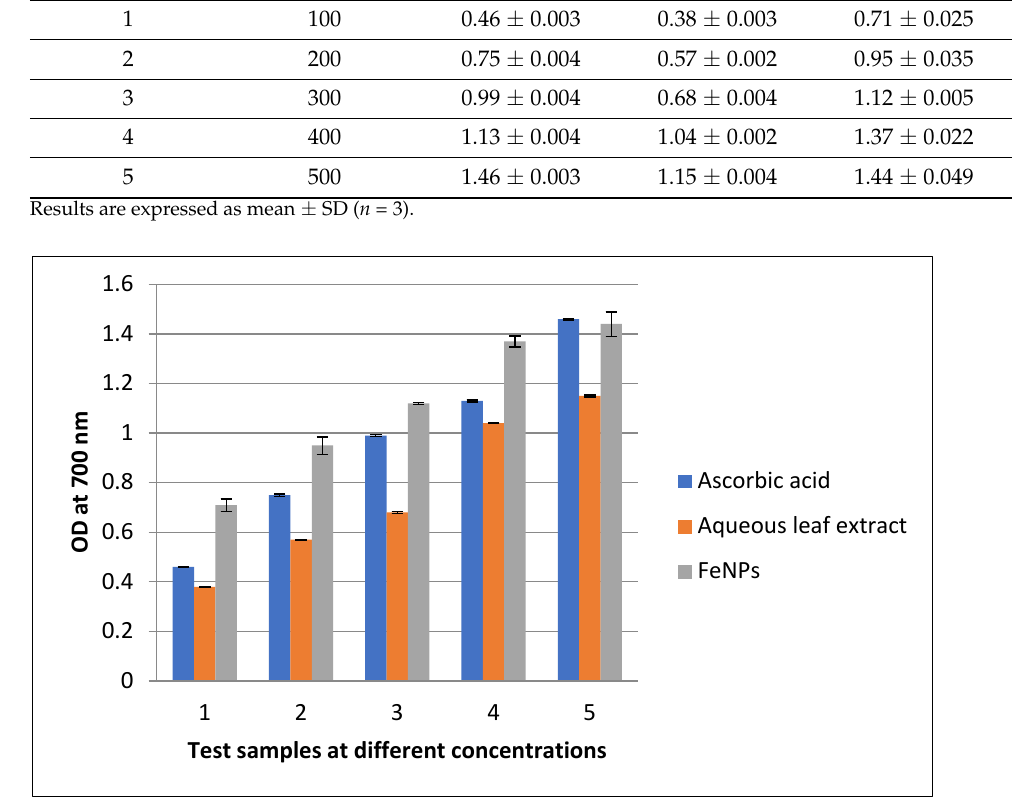
Figure 9. FRAP assay of aqueous leaf extract of V. leucoxylon and its synthesized FeNPs. One of the most used methods for determining the antioxidant capacity of extracts is the H 2 O 2 test. Although hydrogen peroxide is relatively passive, it can have harmful effects on cells by producing hydroxyl radicals and making them poisonous. H 2 O 2 can be eliminated by antioxidants such as phenols, polyphenols, and flavonoids, which protect mammalian cells from hydrogen peroxide damage [48]. The scavenging activity of extracts was determined in this experiment and compared to ascorbic acid, which served as the standard. The assay revealed that FeNPs showed higher activity than plant extract, with percentage of inhibition, i.e., 74.46 ± 0.130, whereas plant extract showed 69.76 ± 0.427 and standard ascorbic acid showed the highest activity with 80.86 ± 0.155 of inhibition (Table 3). Table 3. H 2 O 2 assay of aqueous leaf extract of V. leucoxylon and its synthesized iron nanoparticles.